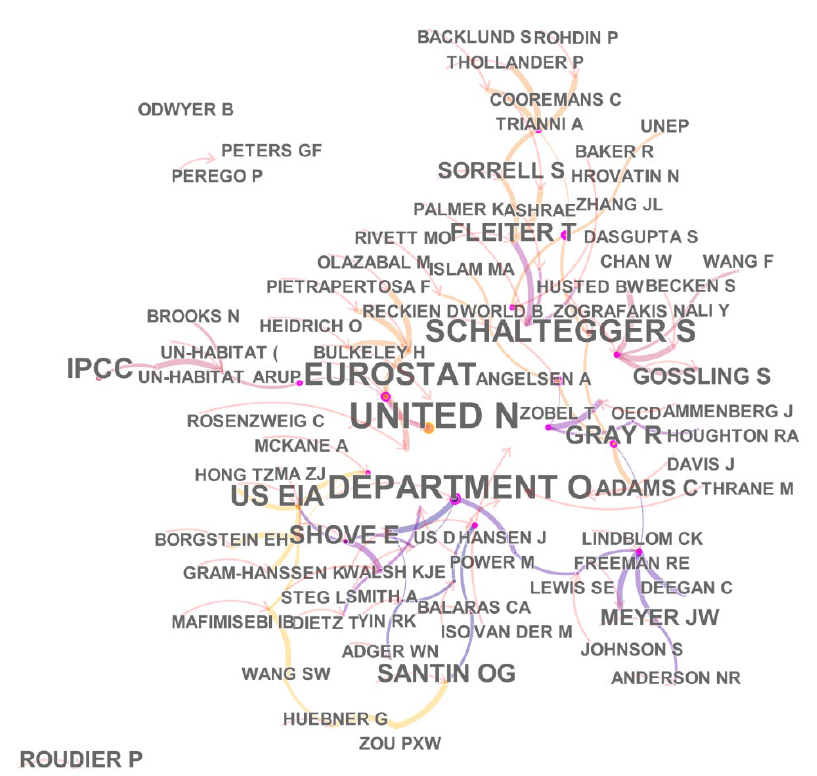
Figure 6. A visualization of the author co-citation network.